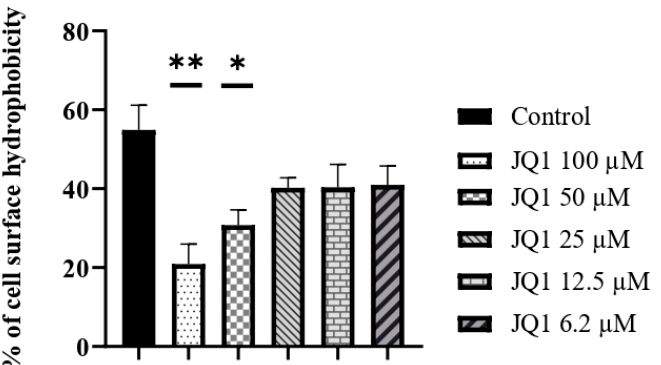
Figure 2. The effect of JQ1 on the surface hydrophobicity of conidia coming from A. fumigatus growth with or without JQ1. The values are reported as the mean of three experiments performed in triplicate. Unpaired Student t -tests to statistical analysis have been performed. * p < 0.05, ** p < 0.01 compared to control.